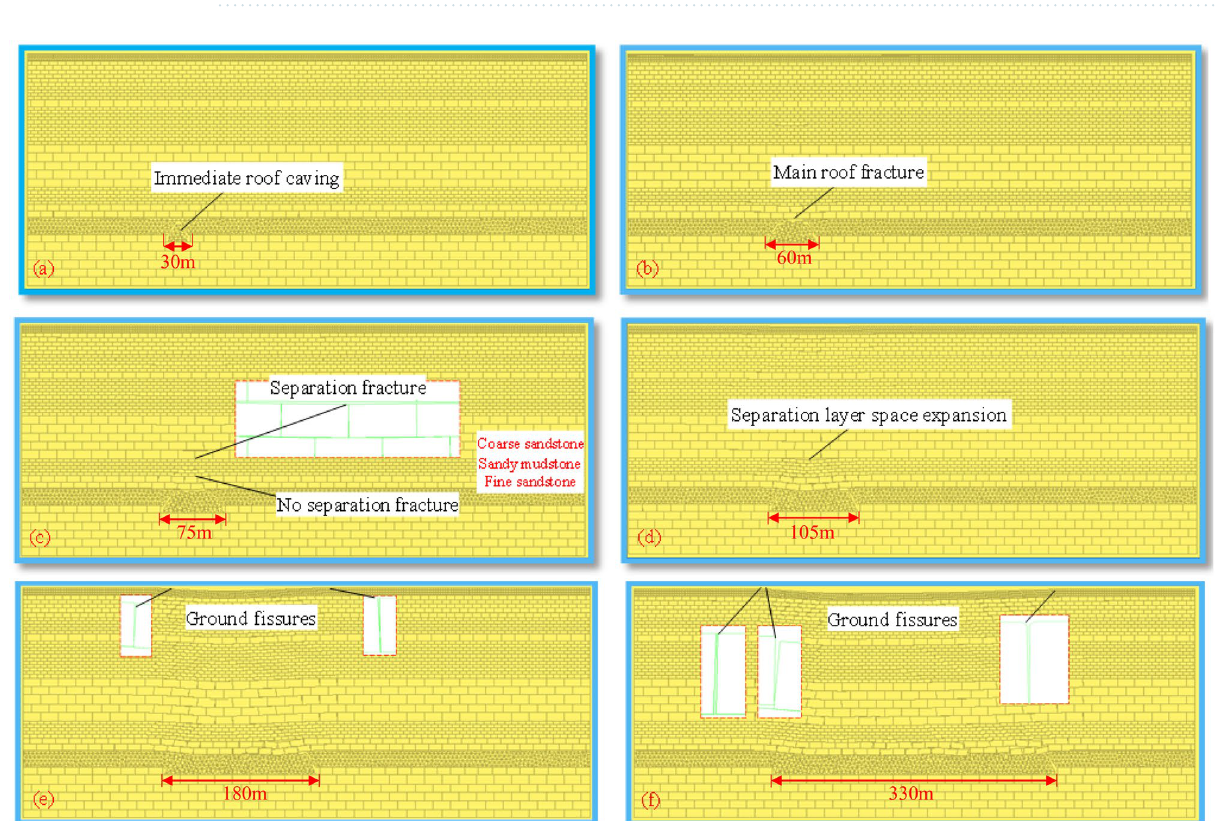
Figure 6. Ground fissures formation process. ( a ) 30 m advancement. ( b ) 60 m advancement. ( c ) 75 m advancement. ( d ) 105 m advancement. ( e ) 180 m advancement. ( f ) 330 m